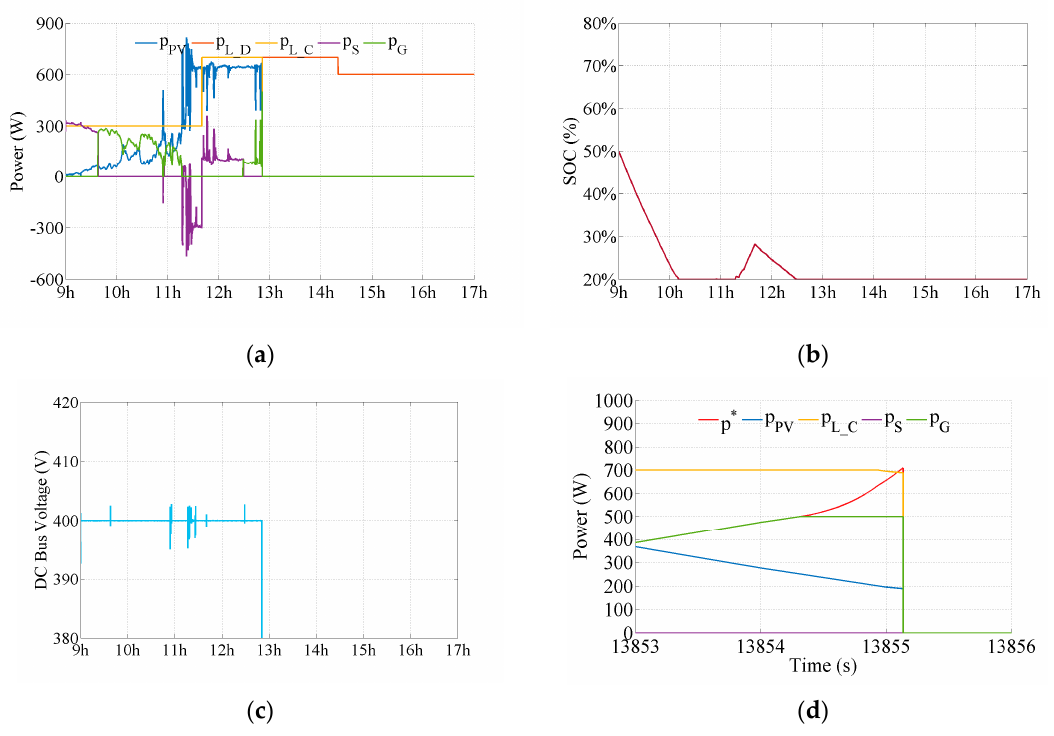
Figure 6. Classical power balancing: ( a ) evolution of each microgrid power; ( b ) SOC evolution; ( c ) bus voltage evolution; ( d ) zoomed view of powers when the microgrid fails.